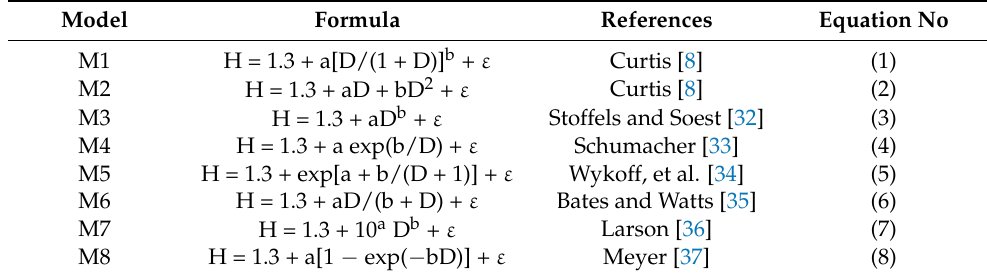
Table 1. Candidate height-diameter